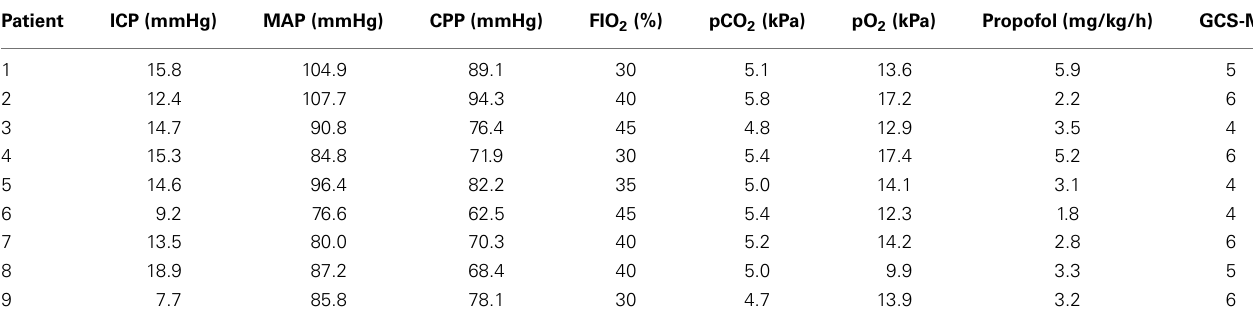
Table 2 | Physiological parameters and neurological grade during the Xenon-CT CBF measurements are presented for each patient . Patient ICP